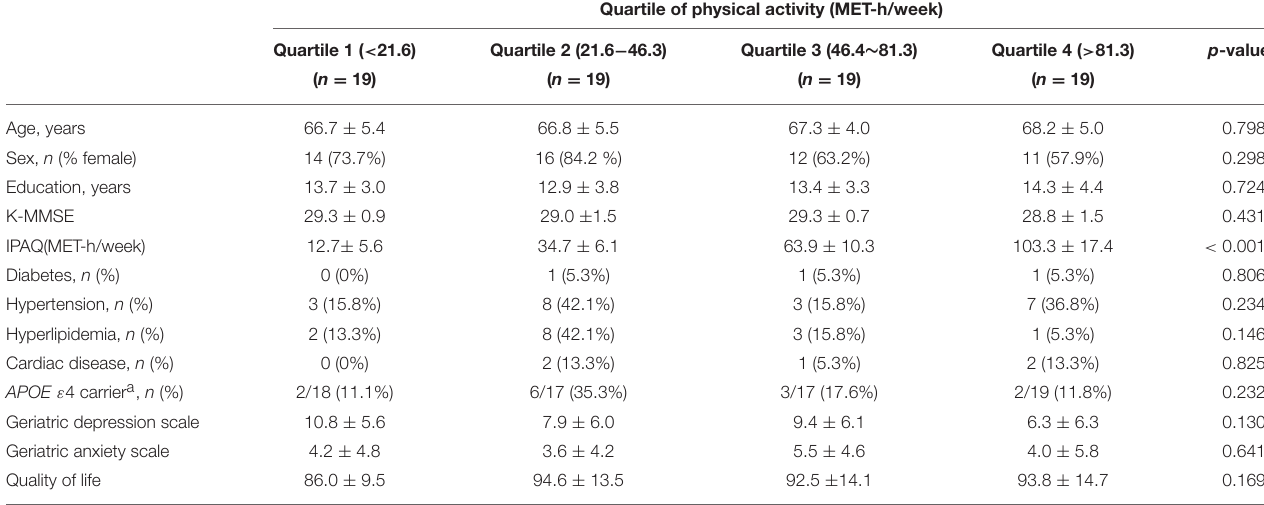
TABLE 1 | Demographic characteristics of the study